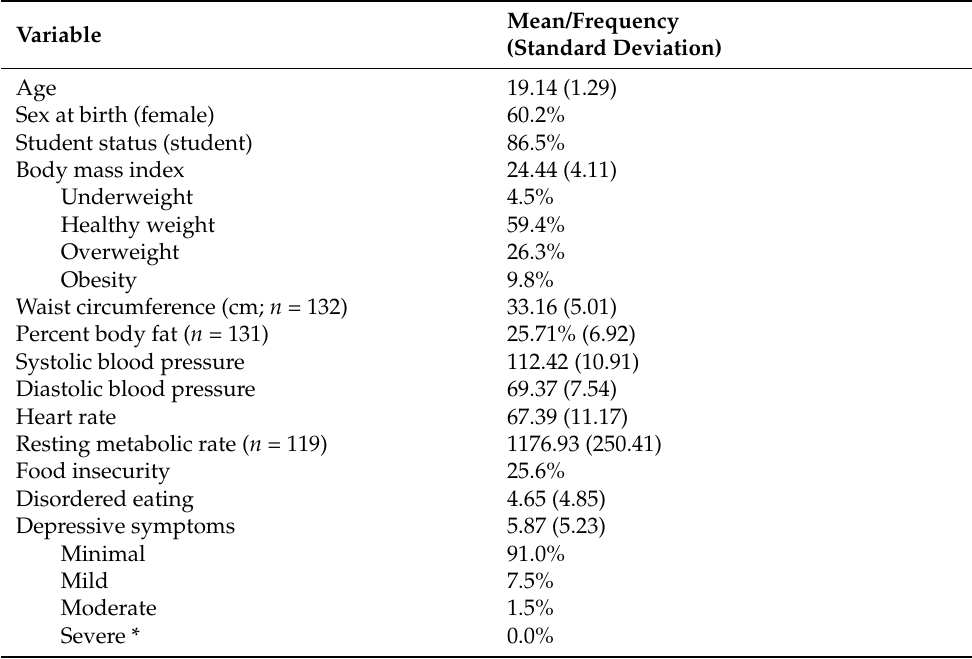
Table 1. Descriptive statistics of the variables of interest ( N = 133).